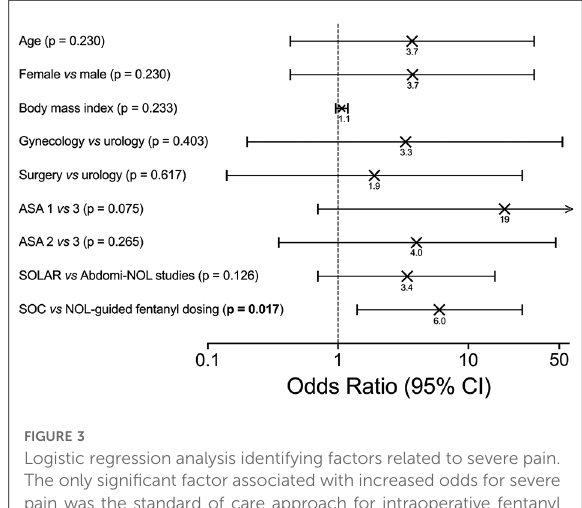
FIGURE 3 Logistic regression analysis identifying factors related to severe pain. The only signi fi cant factor associated with increased odds for severe pain was the standard of care approach for intraoperative fentanyl dosing compared to NOL-guided